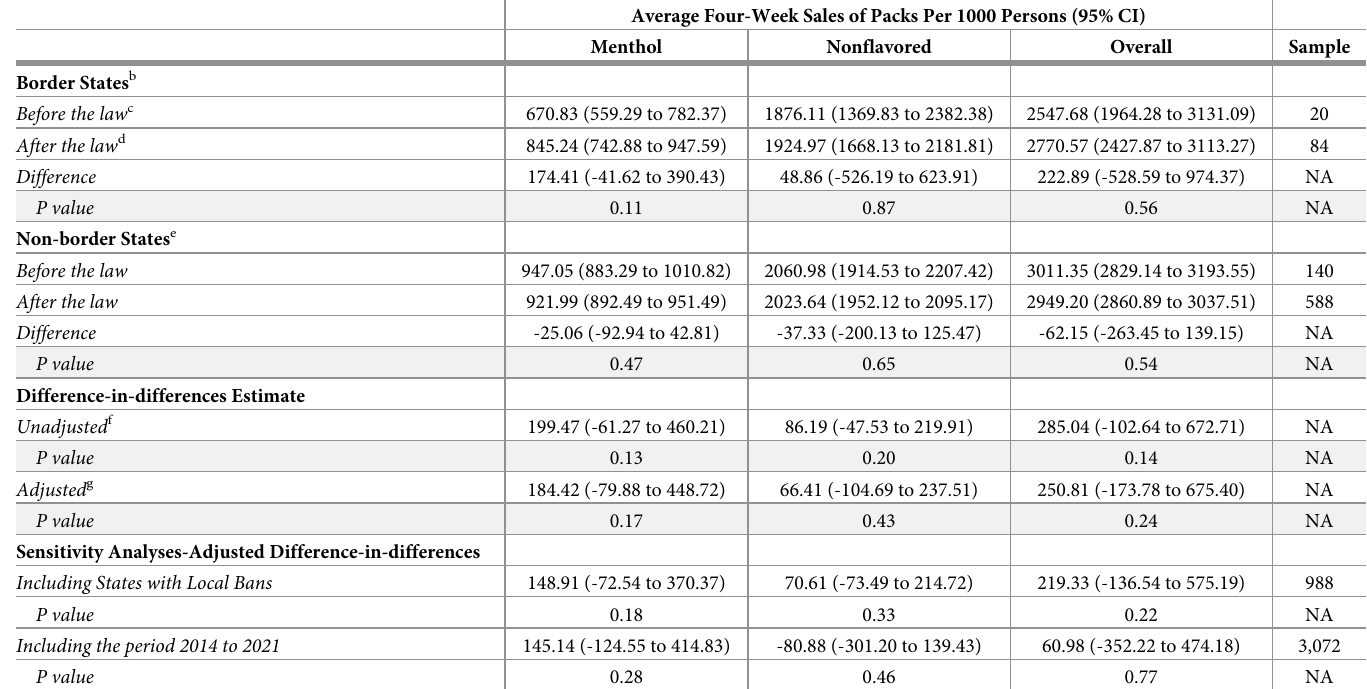
Table 2. Cigarette sales a of border versus non-border states, before and after Massachusetts law prohibiting flavored tobacco products